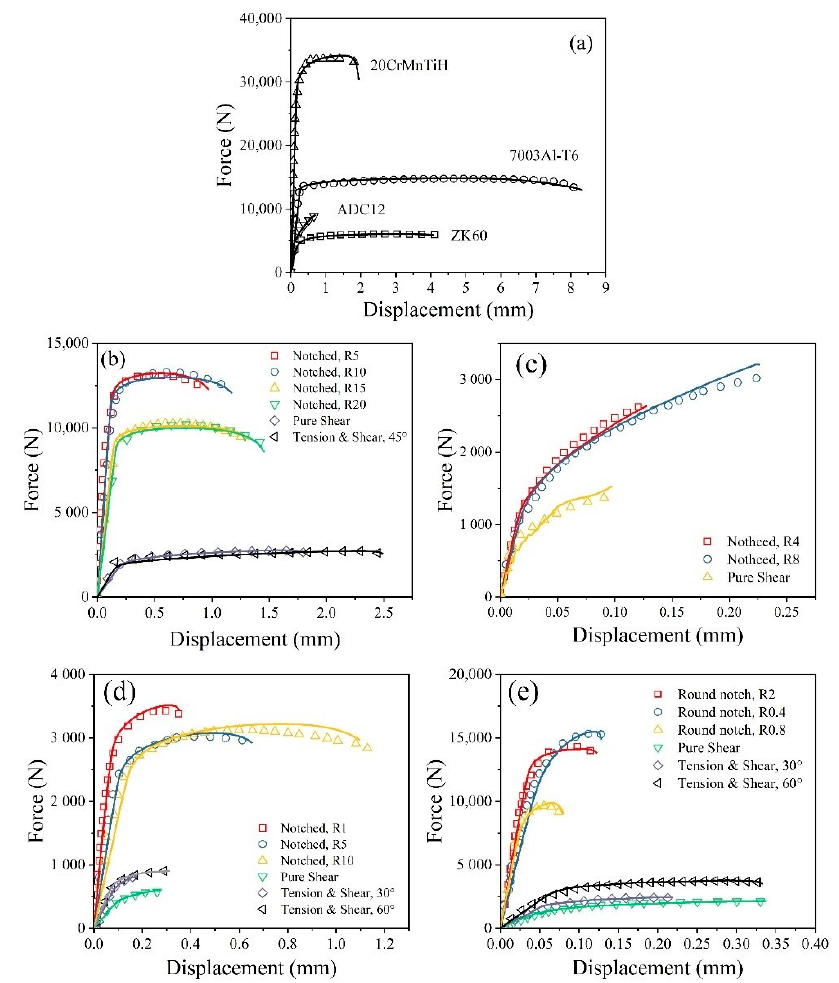
Figure 5. Numerical and experimental force and displacement curves. ( a ) Tensile tests, ( b ) notched and shear tests for 7003 aluminum alloy, ( c ) notched and shear tests for ADC12 aluminum alloy, ( d ) notched and shear tests for ZK60 magnesium alloy and ( e ) notched and shear tests for 20CrMnTiH steel. Scatters represent experimental data and solid lines represent numerical results hereinafter.